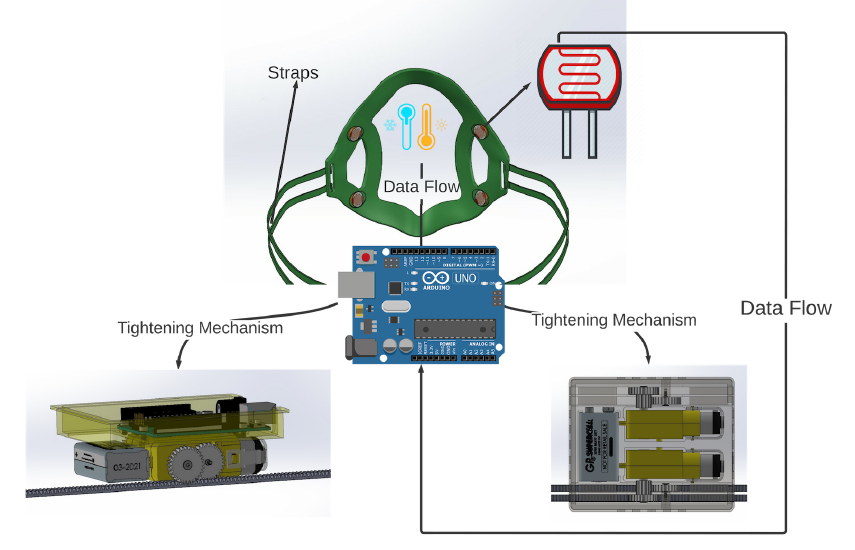
Figure 1. Prototype of the 3D smart